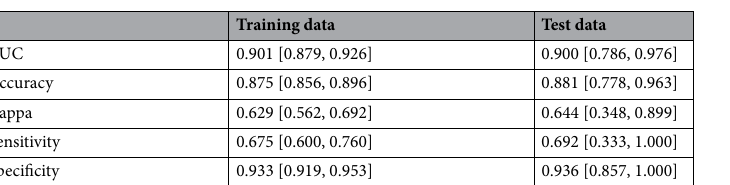
Classification results of the final model: logistic model with three features. The logistic model, which contains only three variables, performed well on all our performance measures. The classification results with the training data and the test data, calculated as the means of the 100 repetitions, are summarized together with their 95% confidence intervals in Table 3. It is interesting to note that our technique with 100 repetitions produces very robust results for the logistic model used here. For the training data and the test data, the mean results are extremely similar. As follows from Fig. 4, performance with the independent test data is worse with both more than three and less than three variables. It is therefore very likely that there is no overfitting in the model with three variables. Regarding the patients in our database, meningiomas with location convexity and falx could be completely resected (i.e. GRT cases) without exceptions. However, most meningiomas with location skull base and pos- terior fossa could not be completely resected (i.e. STR cases) if they had an irregular shape and could also be completely resected (i.e. GTR cases) if they had a regular shape. These usual clinical outcomes, as well as the prediction error rates of our three-factor model using the independent test samples, are summarized in Table 4.